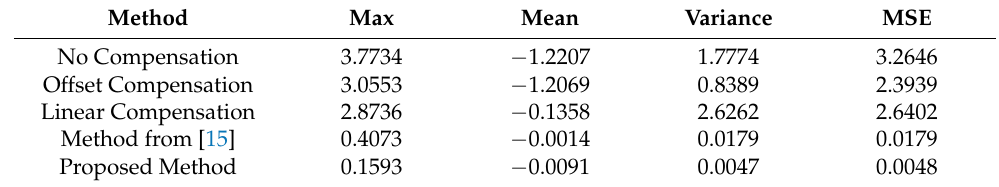
Table 10. Experimental results, with aligned axes, uninclined sensor, and permanent interfering field.